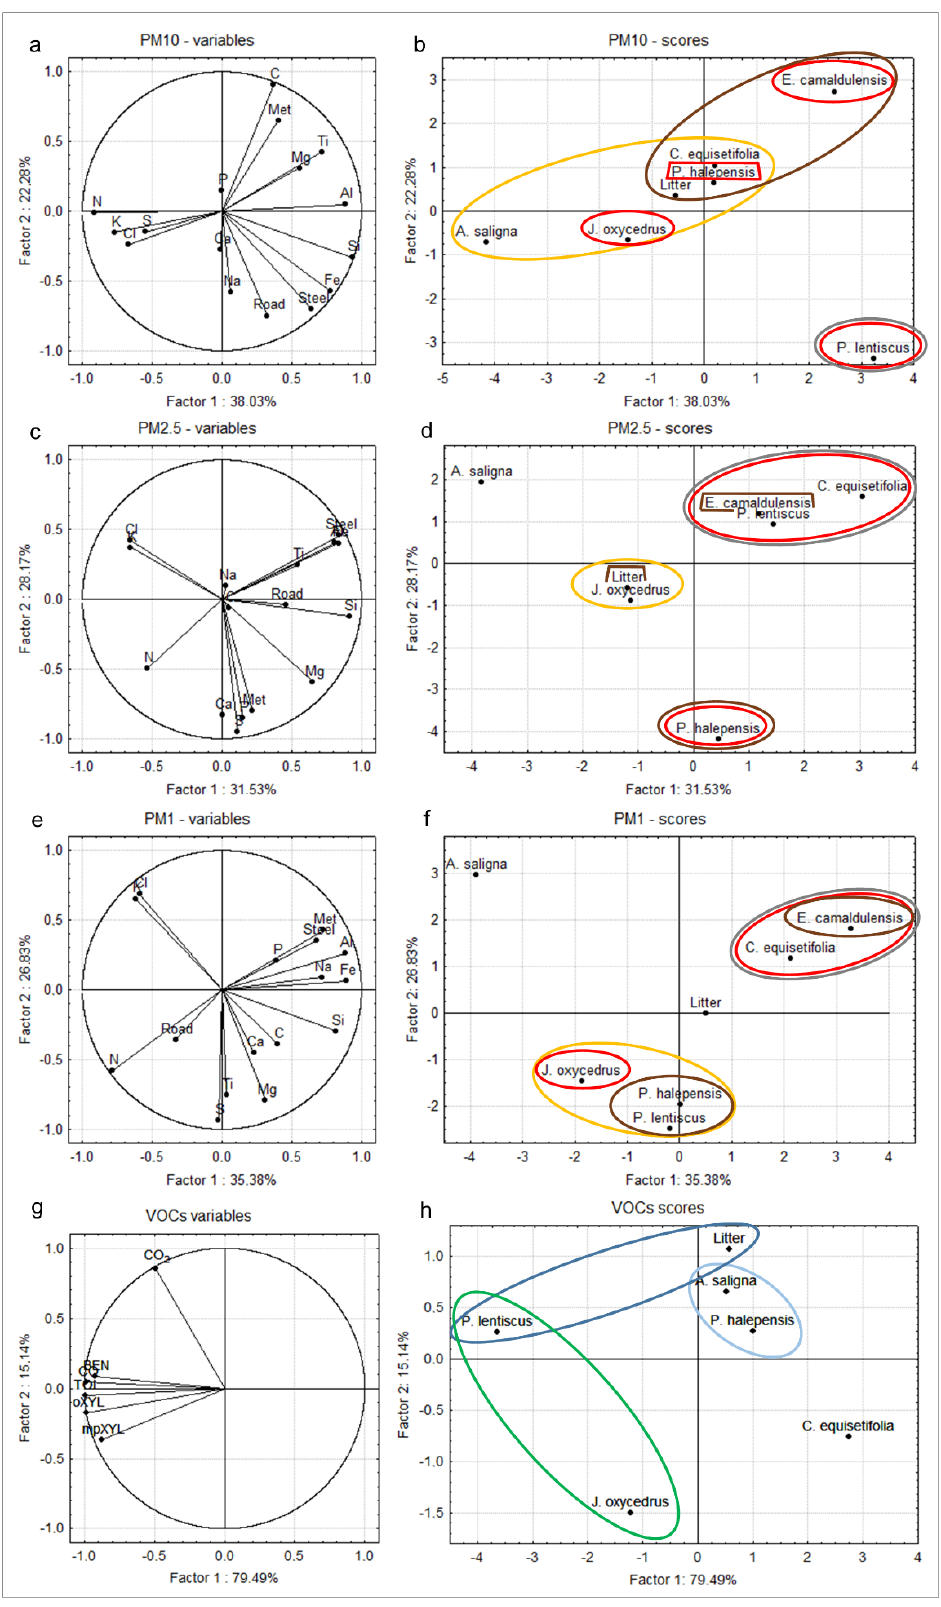
Figure 5. Principal Component Analysis (PCA) for the three dimensional PM classes: ( a , b ) PM10; ( c , d ) PM2.5; ( e , f ) PM1; and for CO, CO 2 and BTXs emitted during combustion experiments: ( g , h ). For each class is reported the factor coordinates of variables graph ( a , c , e , g ), and the factor scores corresponding representation ( b , d , f , h ). Brown rings are used for C-based particles, yellow rings for